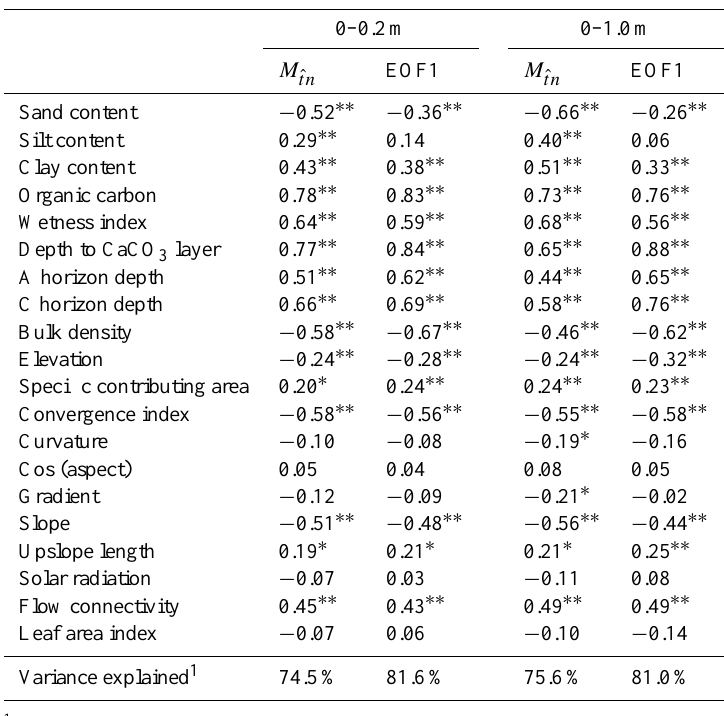
, EOF1 of space-variant temporal anomaly R tn and various prop- tn